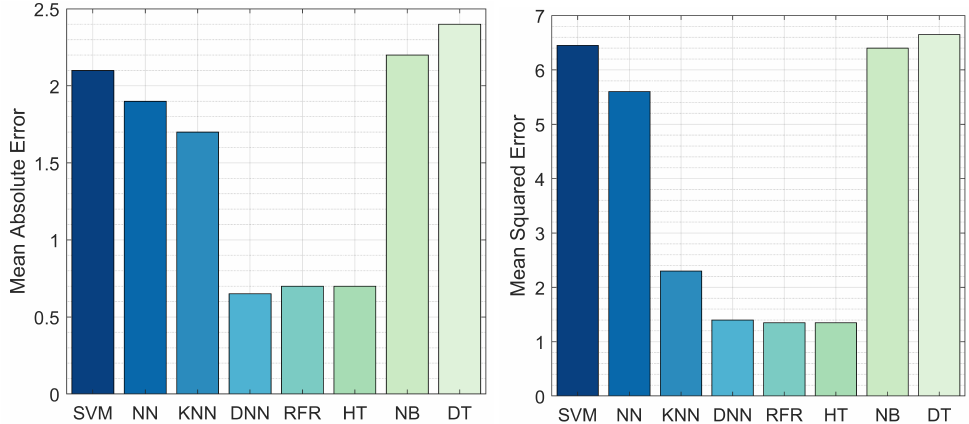
Figure 5. The MAE and MSE of RFR, NN, DNN, SVM, NB, DT, and HT in terms of fault duration